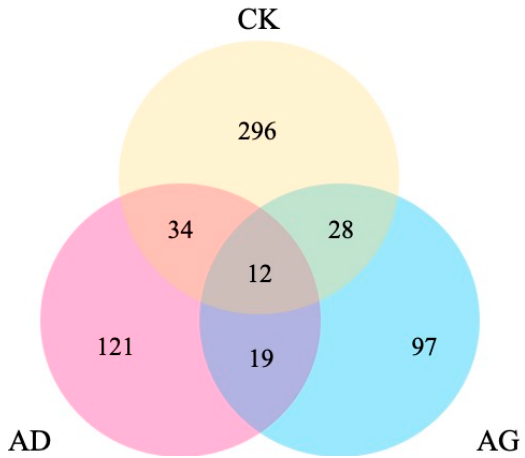
Figure 4. Venn diagram showing the distribution of differentially expressed genes (DEGs) among the transcriptomes. Note: AD, 56.33 mg/mL of α -pinene. AG, 214.5 mg/mL of α -pinene. CK, Table 2. Upregulated and downregulated Bursaphelenchus xylophilus genes induced by α -pinene. Condition Annotation